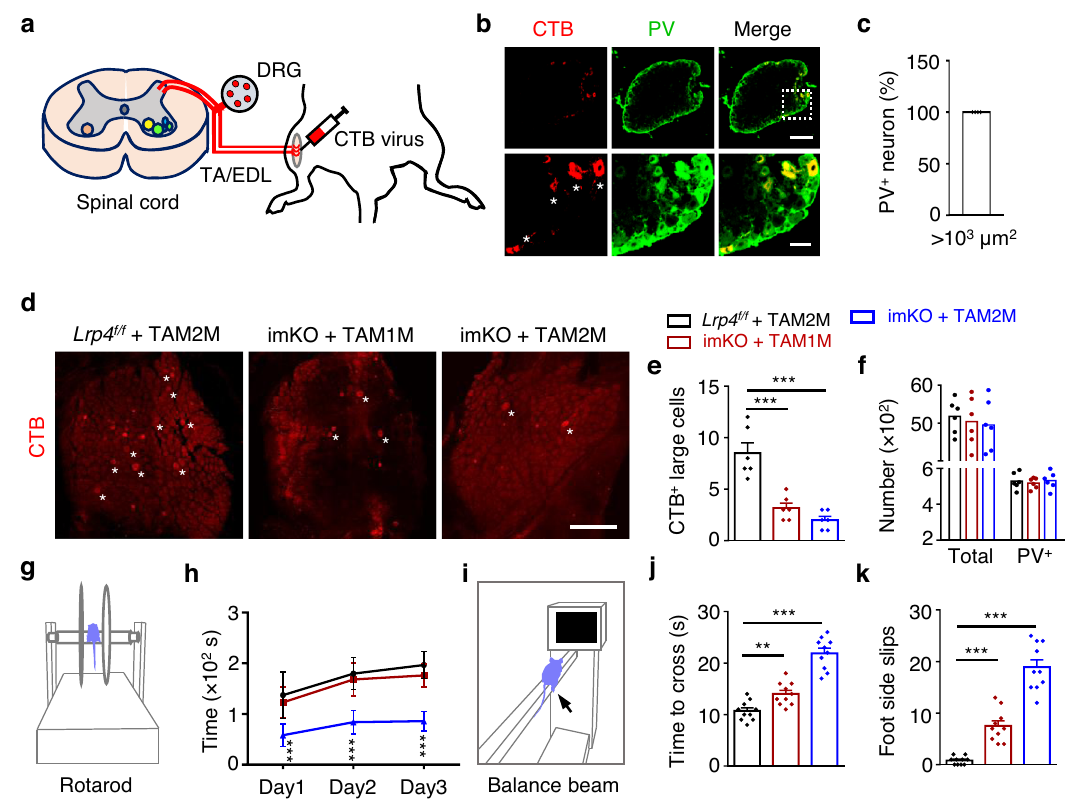
Fig.5|DisruptedsensorysynapsesandproprioceptivesensationinTAM-imKO mice. a Schematic diagram of CTB virus injection and labeling. b Representative images of DRG sections stained with anti-CTB and anti-PV antibodies. CTB colo- calized with PV positive neurons (asterisks). Scale bars, 200 µ m and 50 µ m. c Quanti fi cation of the percentage of CTB labeled large neurons (>1000 µ m 2 ) with PV staining, n =4 sections from 4 mice (P60). d Representative images of DRG at indicated groups labeled by CTB. The positive neurons with soma size larger than 1000 µ m 2 were counted (asterisks). Scale bar, 300 µ m. e Quanti fi cation of CTB labeled large neuron in ( d ); t (10) =4.846, *** p =0.0007; t (10) = 6.151, *** p =0.0001, n =6 mice per group, unpaired two-tailed t test. f Quanti fi cation of total neurons and PV + neurons in each group. n =6 mice per group. g Rotarod test. h Quanti fi cationofthetimemiceineachgroupfallofftherotatingrodonthe fi rst,